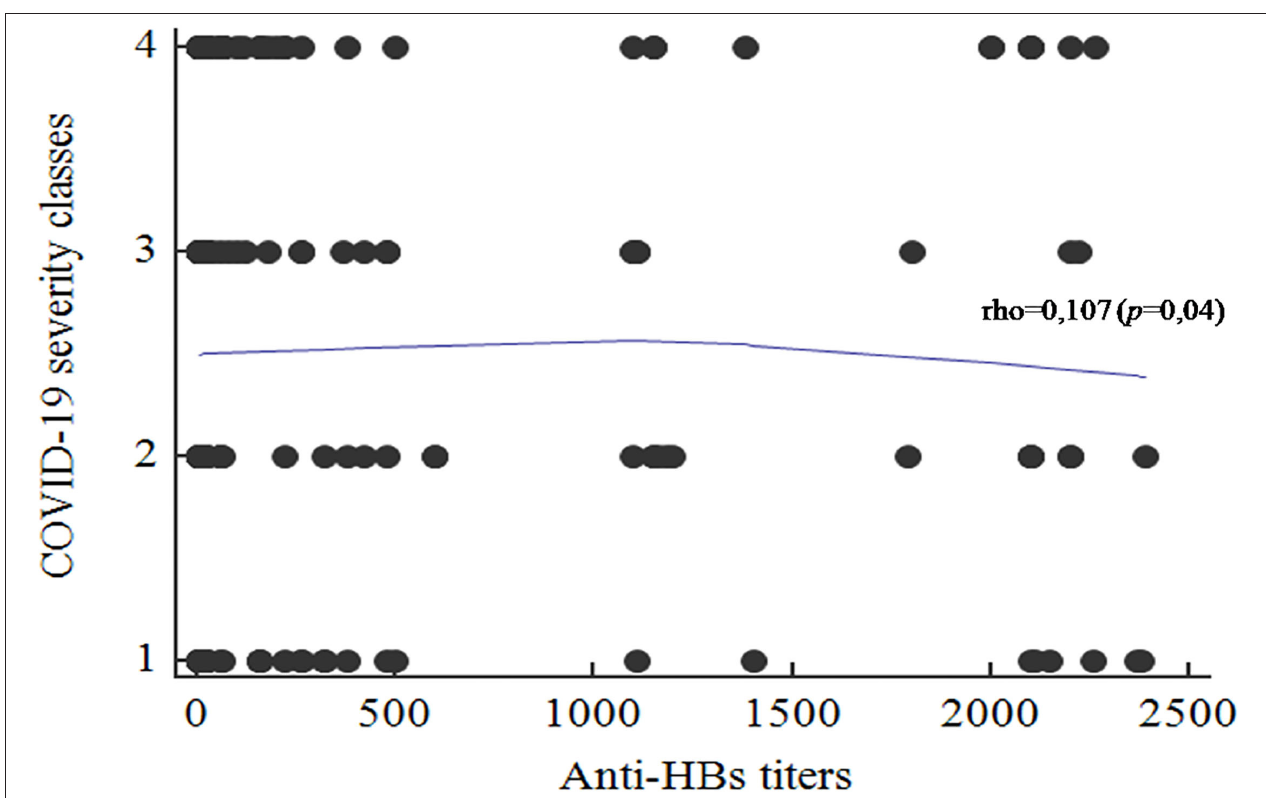
FIGURE 4 | Correlation between the anti-HBs titers and the COVID-19 disease severity classes (1, Asymptomatic; 2, Mild; 3, Moderate; 4,